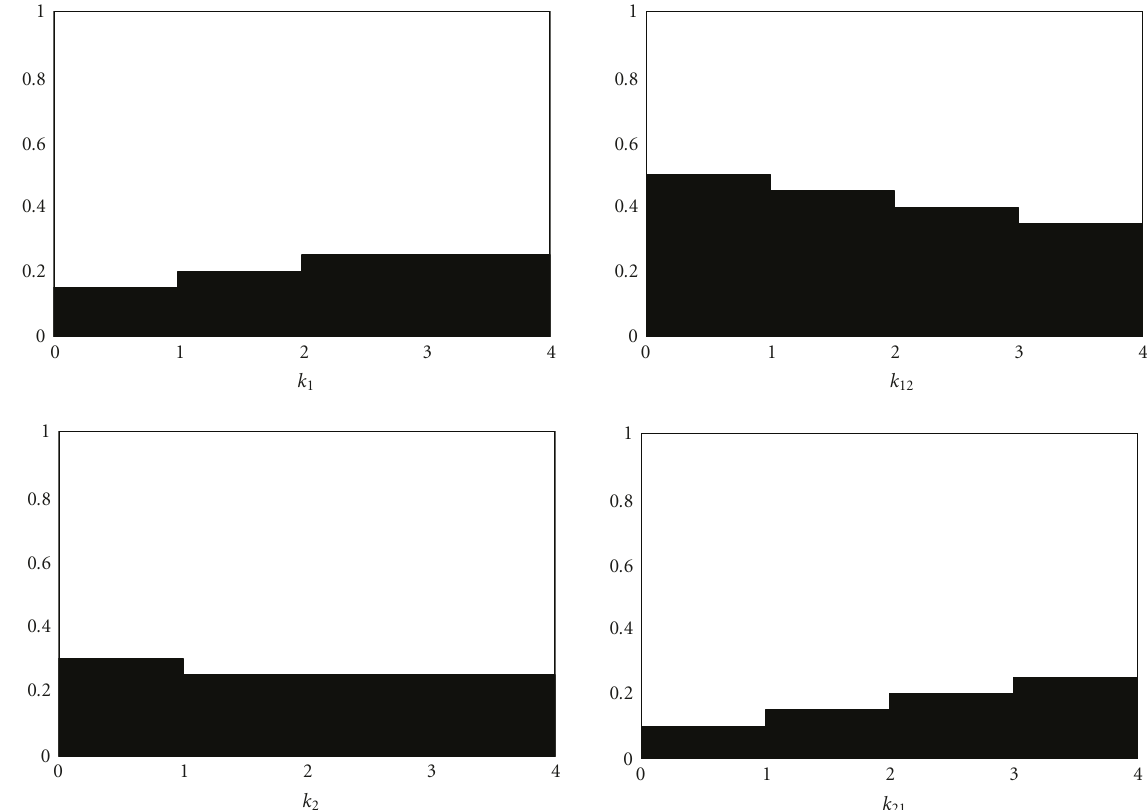
Figure 7: The variation of k parameters due to the nonuniform tra ffi c in the central